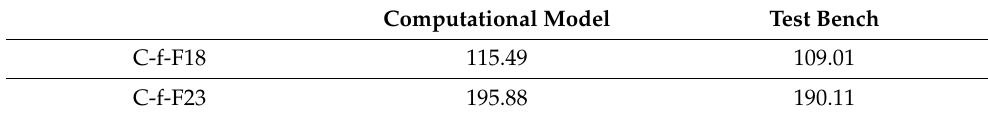
Table 1. Resultant accelerations (m s − 2 ) of trunk shaker free for both models.